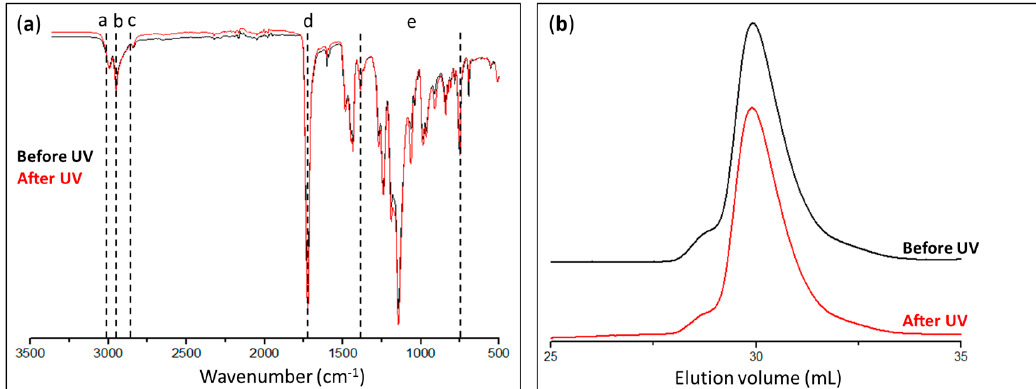
Figure 7. ( a ) Infrared spectra and ( b ) chromatograms of PMMA synthesized in solution before (black curves) and after (red curves) exposure to UV radiation.